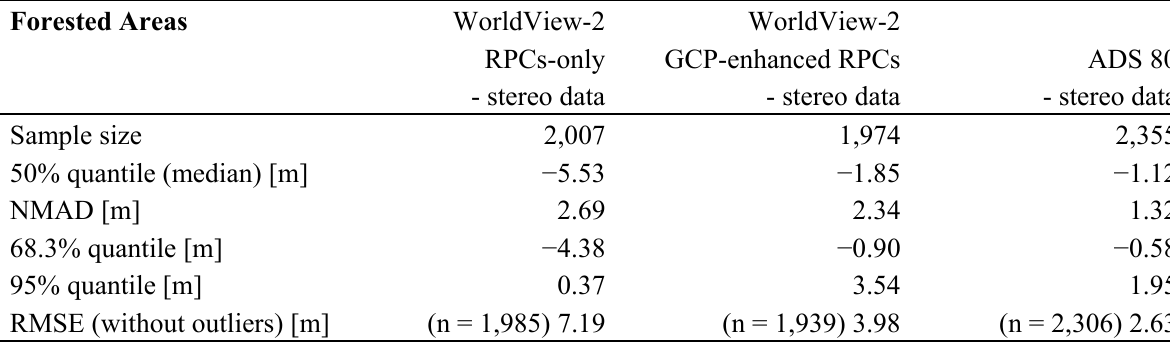
Table 5. Forested areas. Vertical agreement measures of the three digital surface models in comparison with the stereo-measurements.